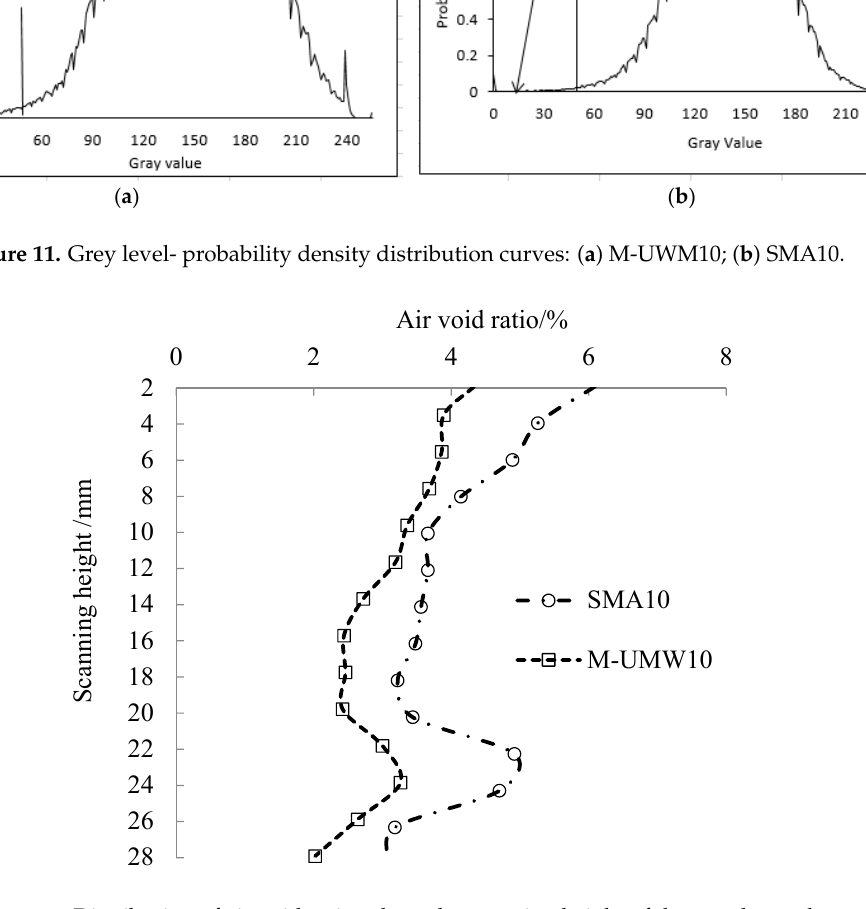
Figure 12. Distribution of air void ratios along the scanning height of the cored samples.